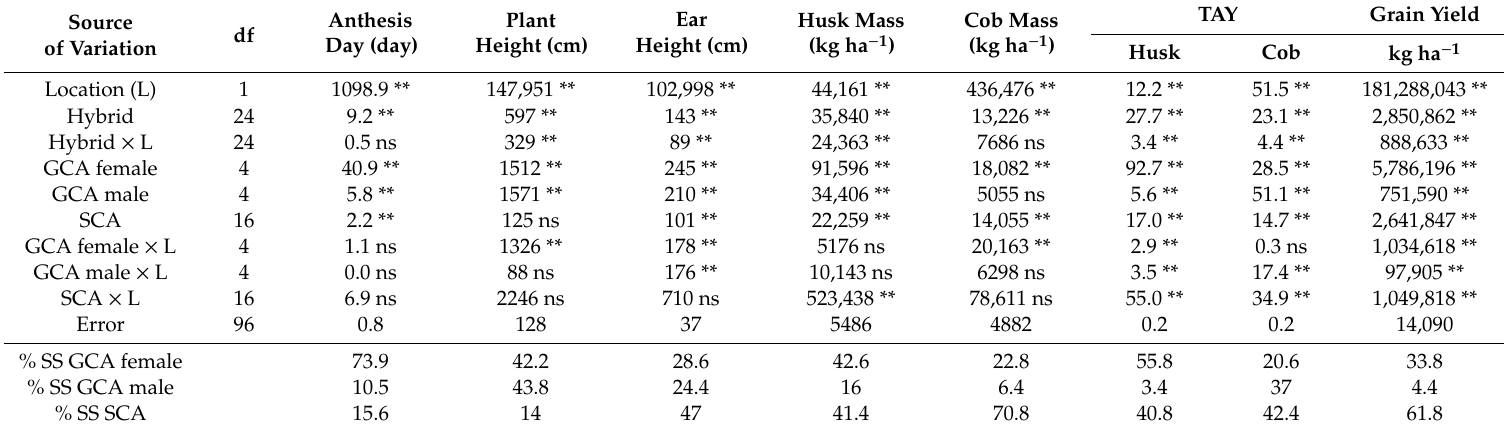
Table 2. Mean squares for agronomic traits, anthocyanin yield, and grain yield of hybrids evaluated across two locations. Source